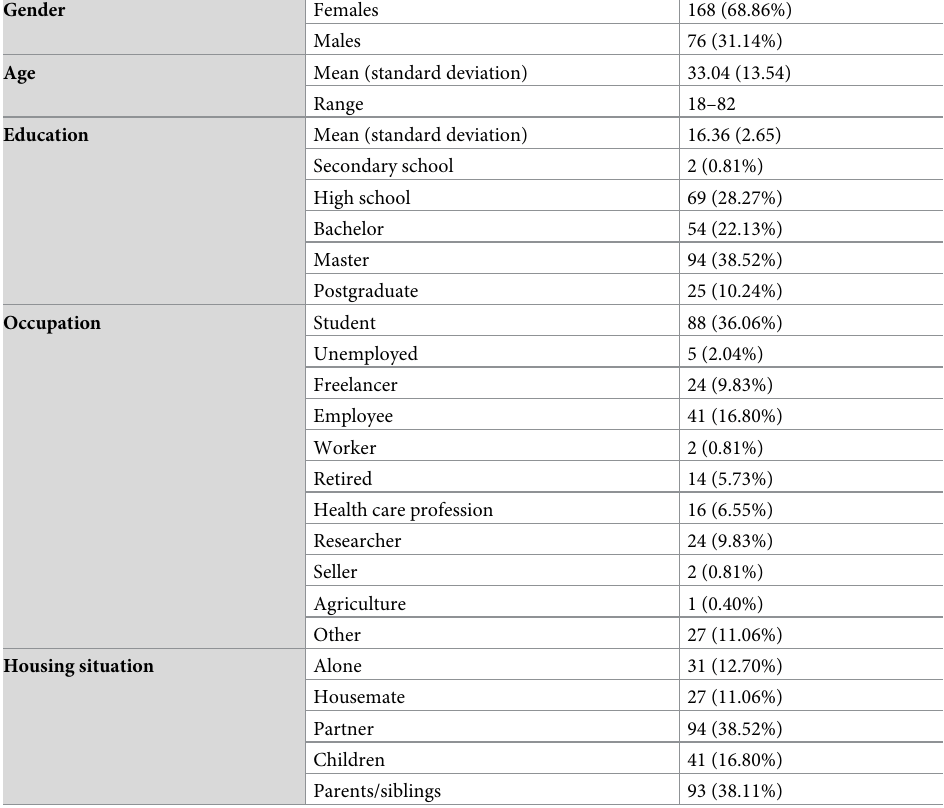
Table 1. Summary of the socio-demographic characteristics of the sample.